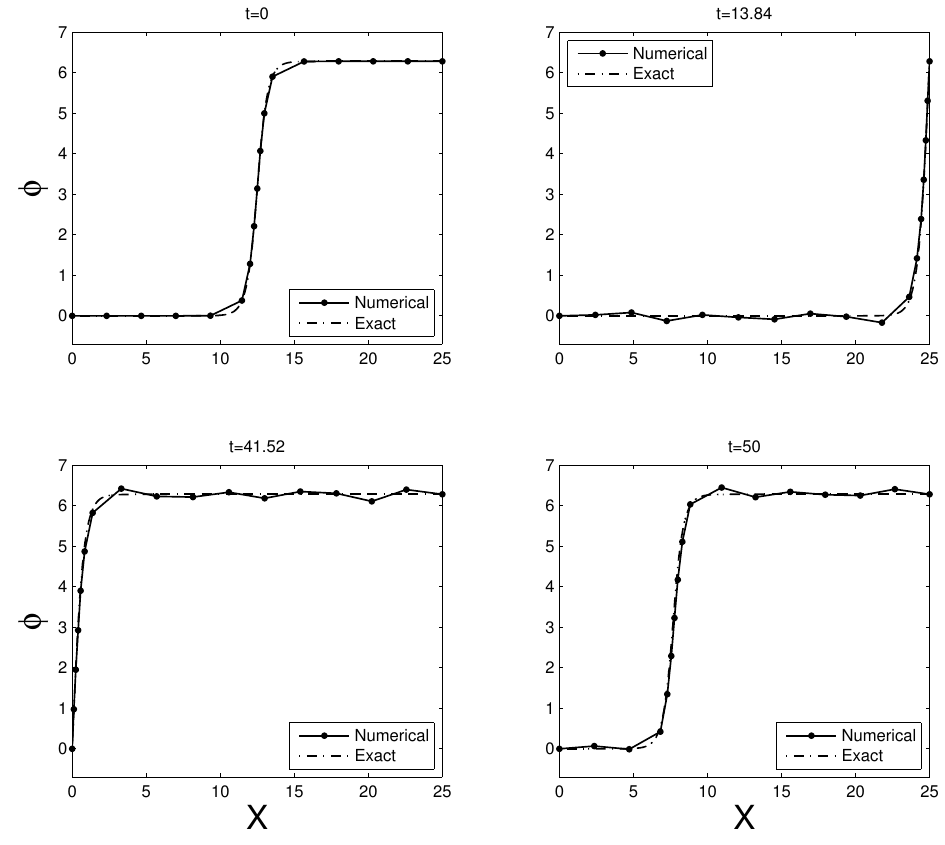
Figure 4. The single soliton solution obtained with the Lagrange multiplier strategy for N = 15. Integration in time was performed using the 4th order Lobatto IIIA–IIIB scheme for constrained mechanical systems. The soliton moves to the right with the initial velocity v = 0.9, bounces from the right wall at t = 13.84, and starts moving to the left with the velocity v = − 0.9, towards the left wall, from which it bounces at t =